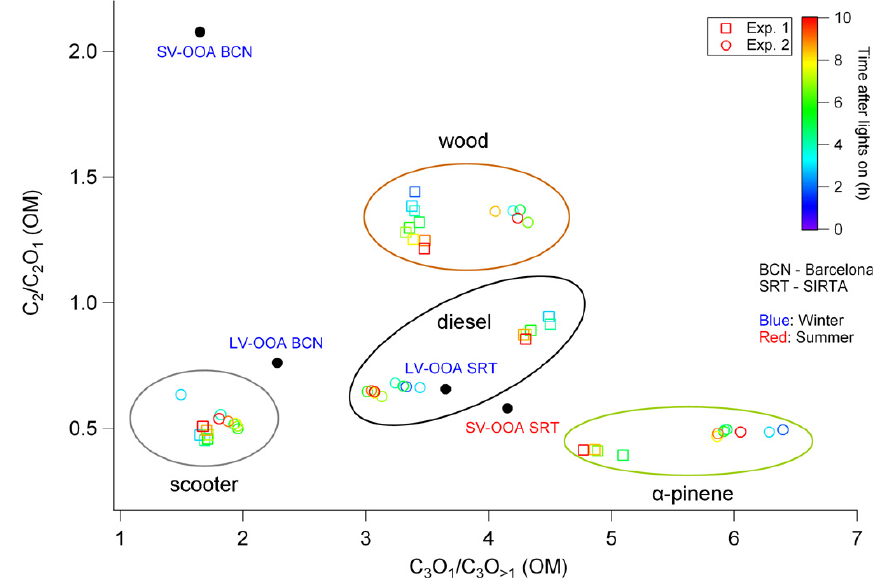
Fig. 7. SOA separation based on grouped ions. The symbols represent hourly averages of experiment 1 (squares) and 2 (circles) and are colored according to the aging time. Colored ovals are added to guide the eye and group the duplicate experiments. PMF resolved OOA spectra measured in SIRTA (Paris) and Barcelona are colored according to the